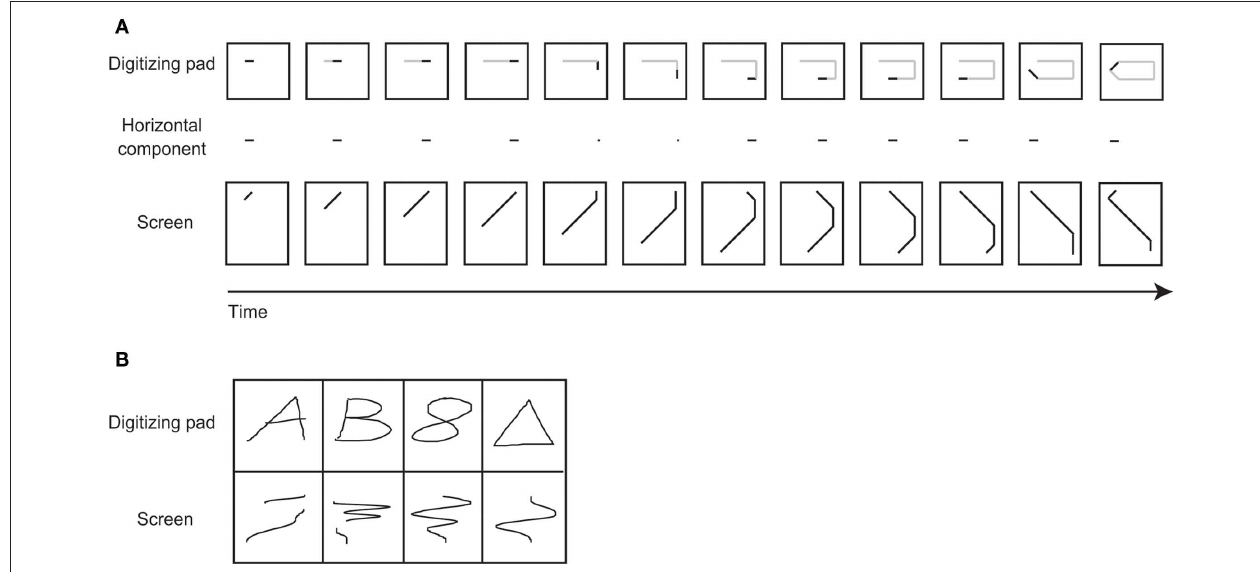
Figure 1 | (A) How the drawings players produced on the digitizing pad appeared on the screen. (B) How common graphic symbols drawn on the digitizing pad appeared on the screen. (Adapted from Galantucci et al.,